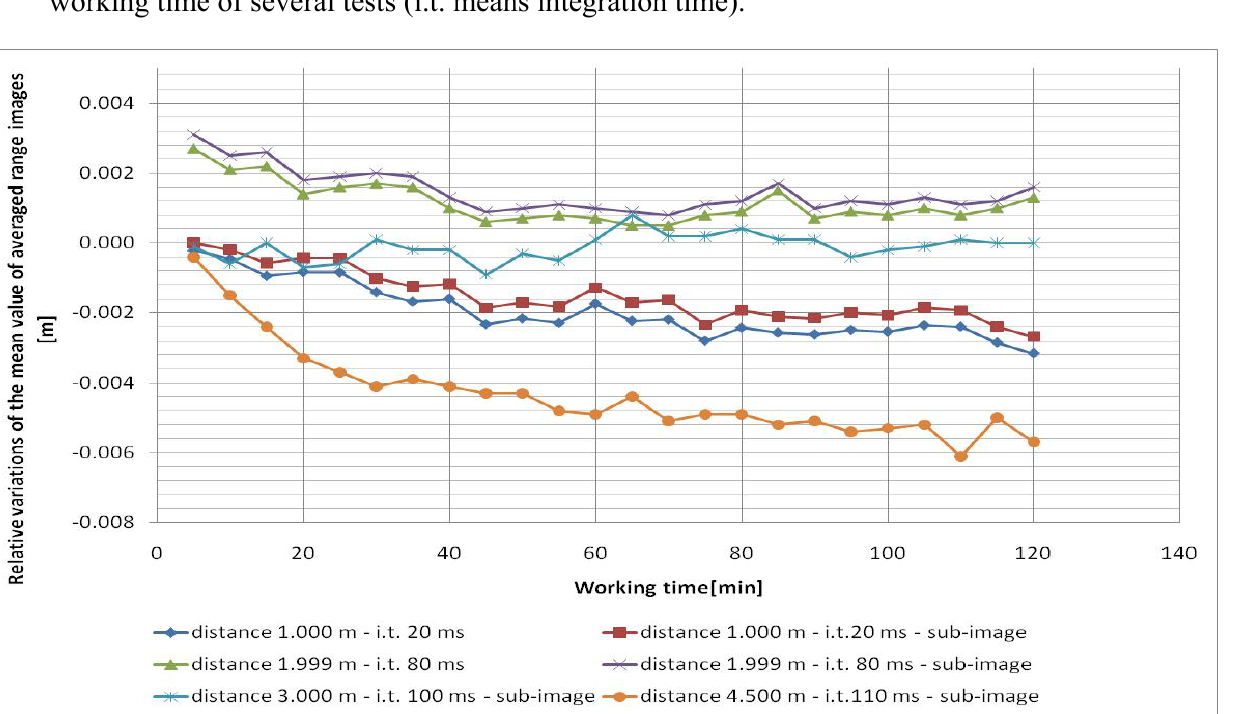
Figure 2. Relative variations of the mean value of averaged range images during the working time of several tests (i.t. means integration